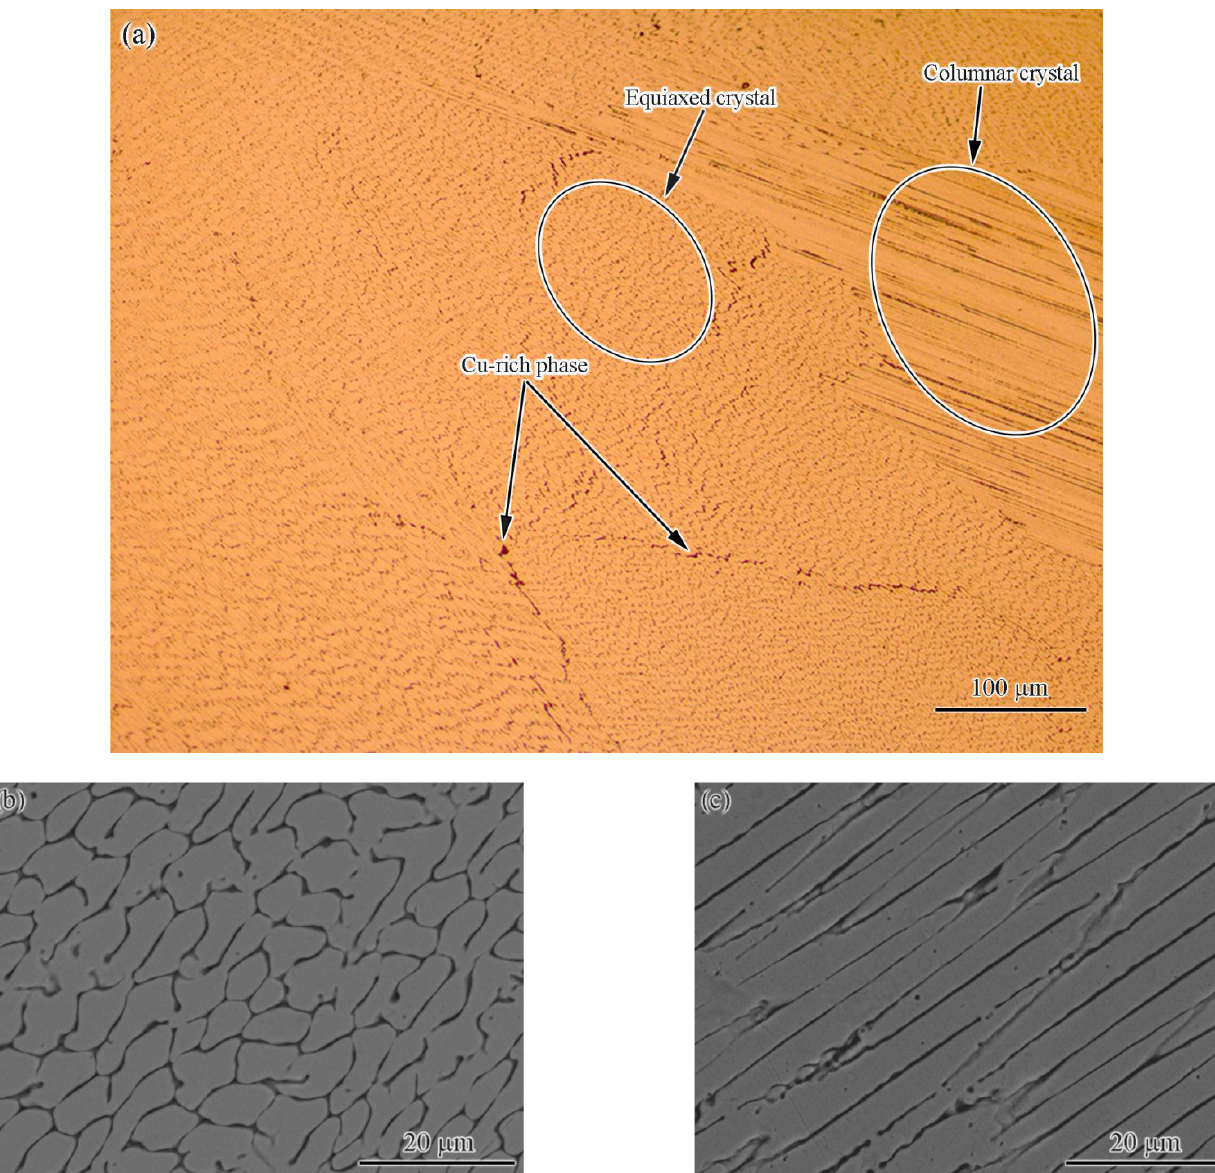
Figure 5. Microstructure of the FZ center of the welded joint at a laser power of 1.85 kW: ( a ) OM, SEM (backscattered electron) images of the ( b ) equiaxed crystals and ( c ) columnar